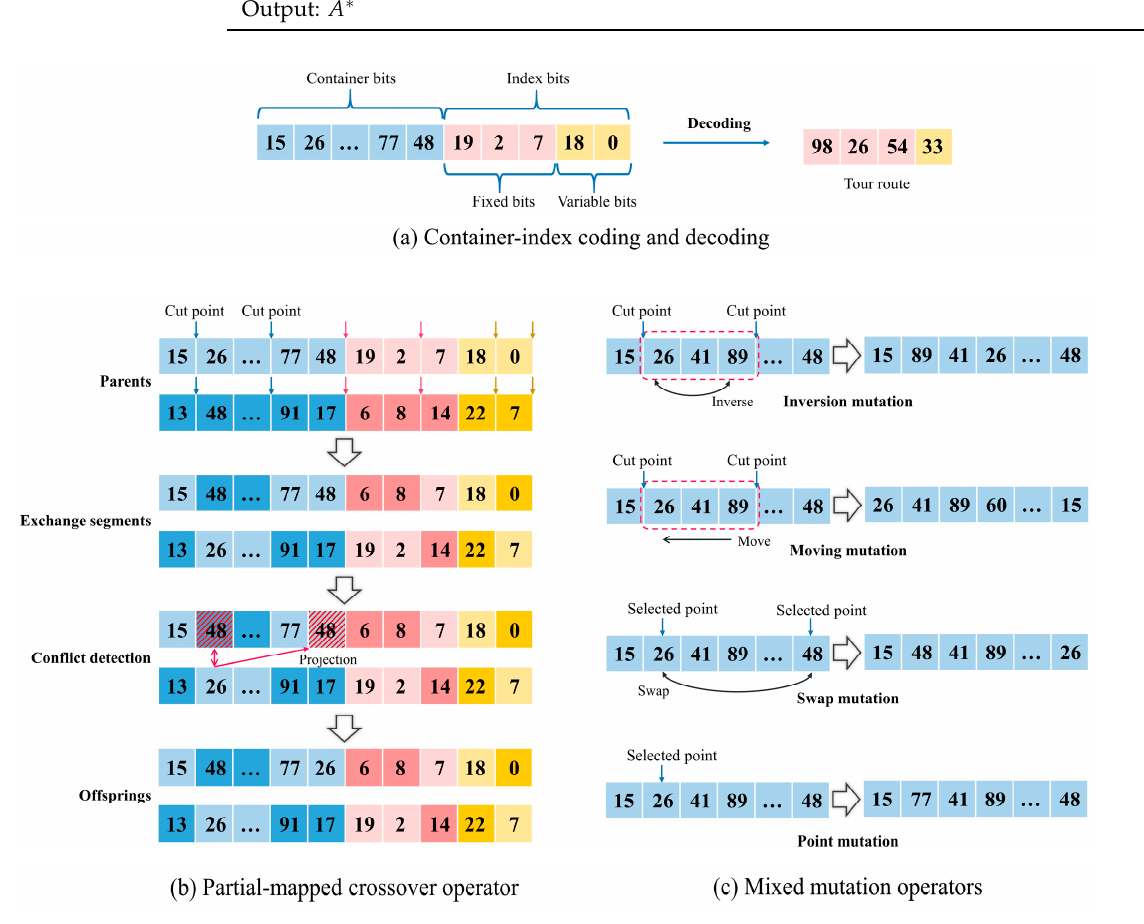
Figure 3. Process of the two-stage route strategy.